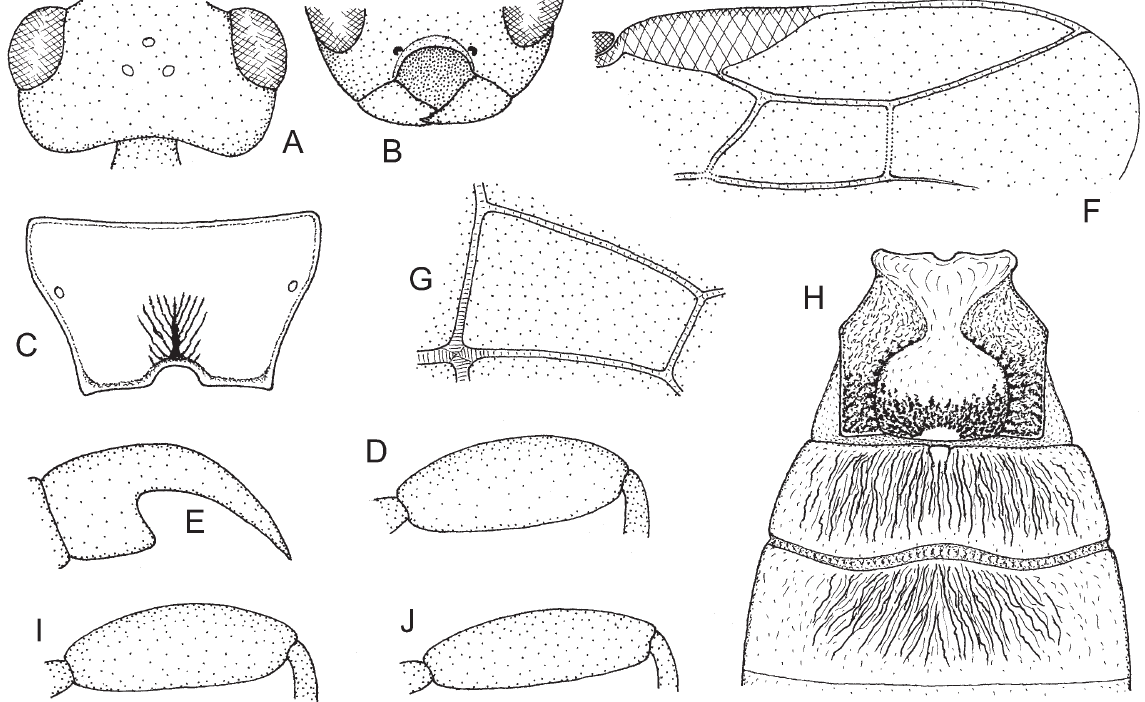
Fig. 10. Bracon ( Lucobracon ) fortipes Wesmael, 1838 (A-H: ♀ holotype, I - J: ♀ / ♂). A . Head in dorsal view. B . Head in frontal view. C . Propodeum. D . Hind femur. E . Claw. F . Distal part of right forewing. G . First discal cell of right forewing. H . Tergites 1-3. I-J . Hind